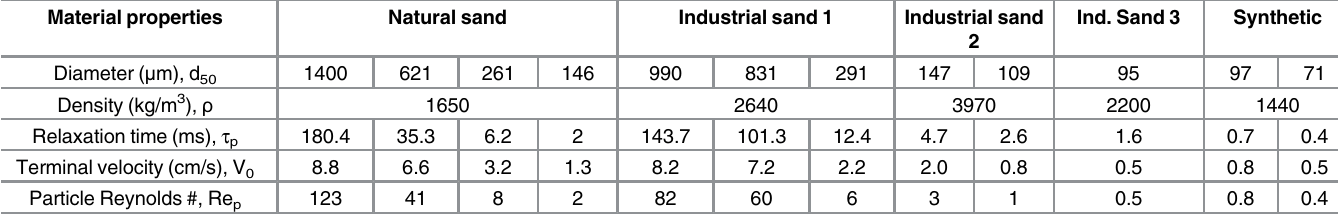
turbulent fluctuations. The particle Reynolds number is based on the particle diameter, the Table 1. Particle